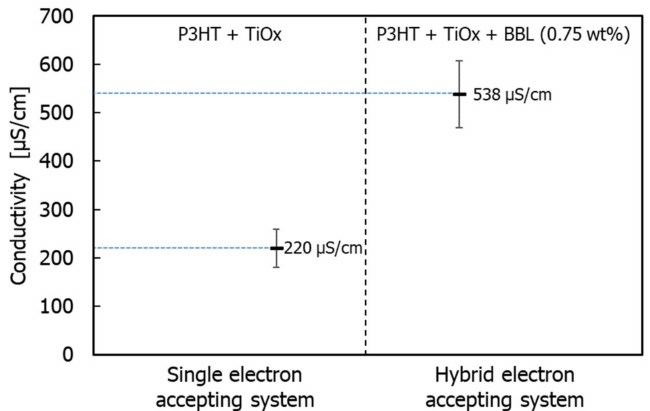
Figure 7. Individual value of electrical conductivity of photoactive layers.